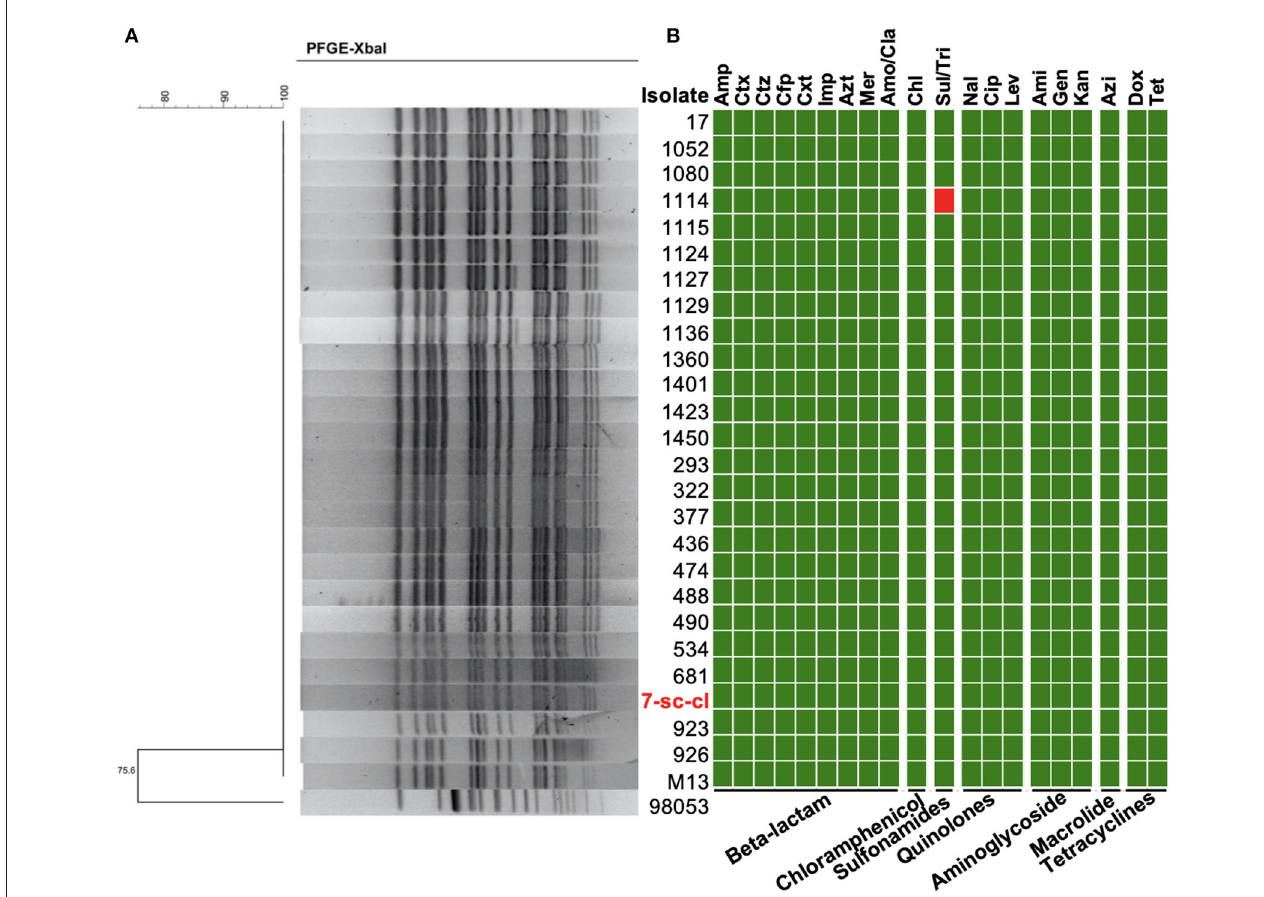
FIGURE 2 | Molecular characterization of S. Typhi outbreak isolates. (A) PFGE patterns of the S. Typhi isolates digested with Xbal I. PFGE was conducted using 26 isolates in this study and a S. Typhi strain not related to this outbreak (98,053) was used as the control. (B) Minimum inhibitory concentration of the outbreak isolates. MICs of 20 antimicrobials belonging to seven antimicrobial classes were tested. The resistance (red block) and susceptibility (green block) of isolates to the antibiotics were indicated using different colors.